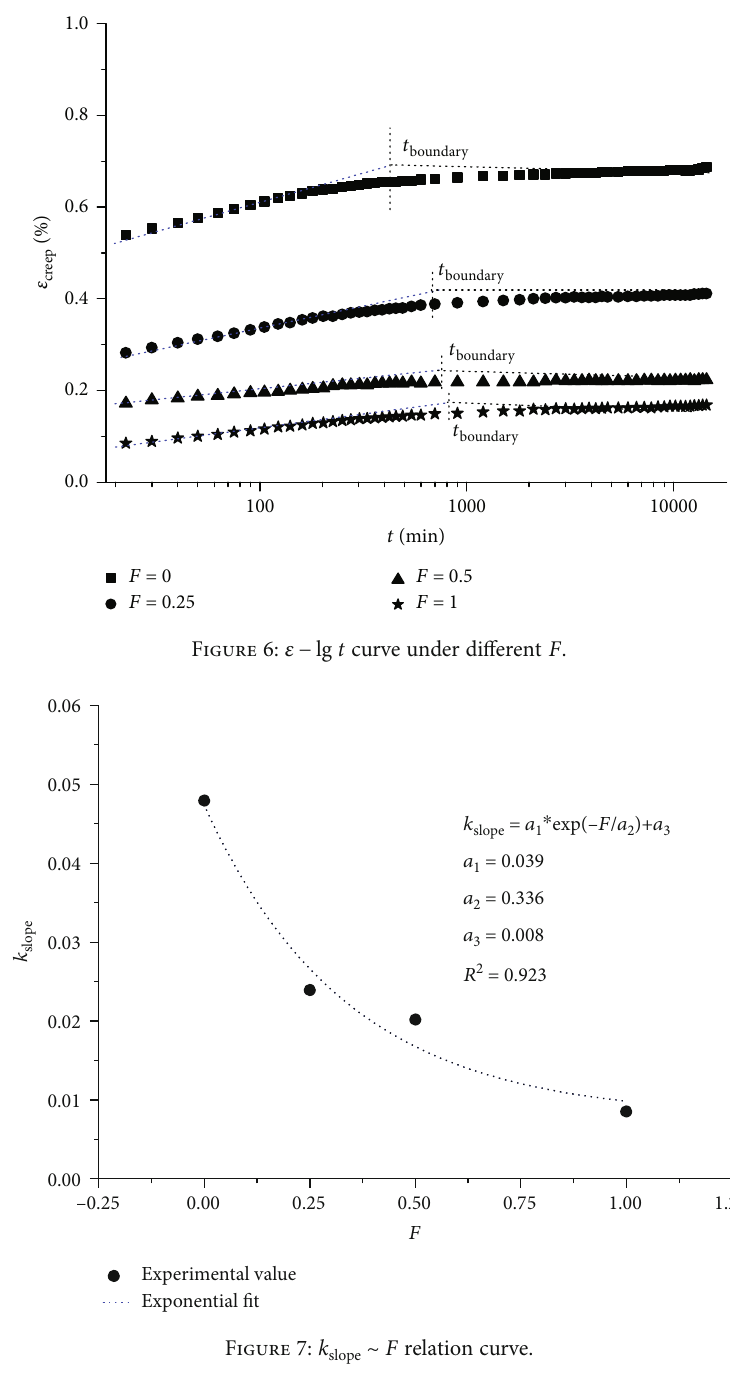
~ F relation slope